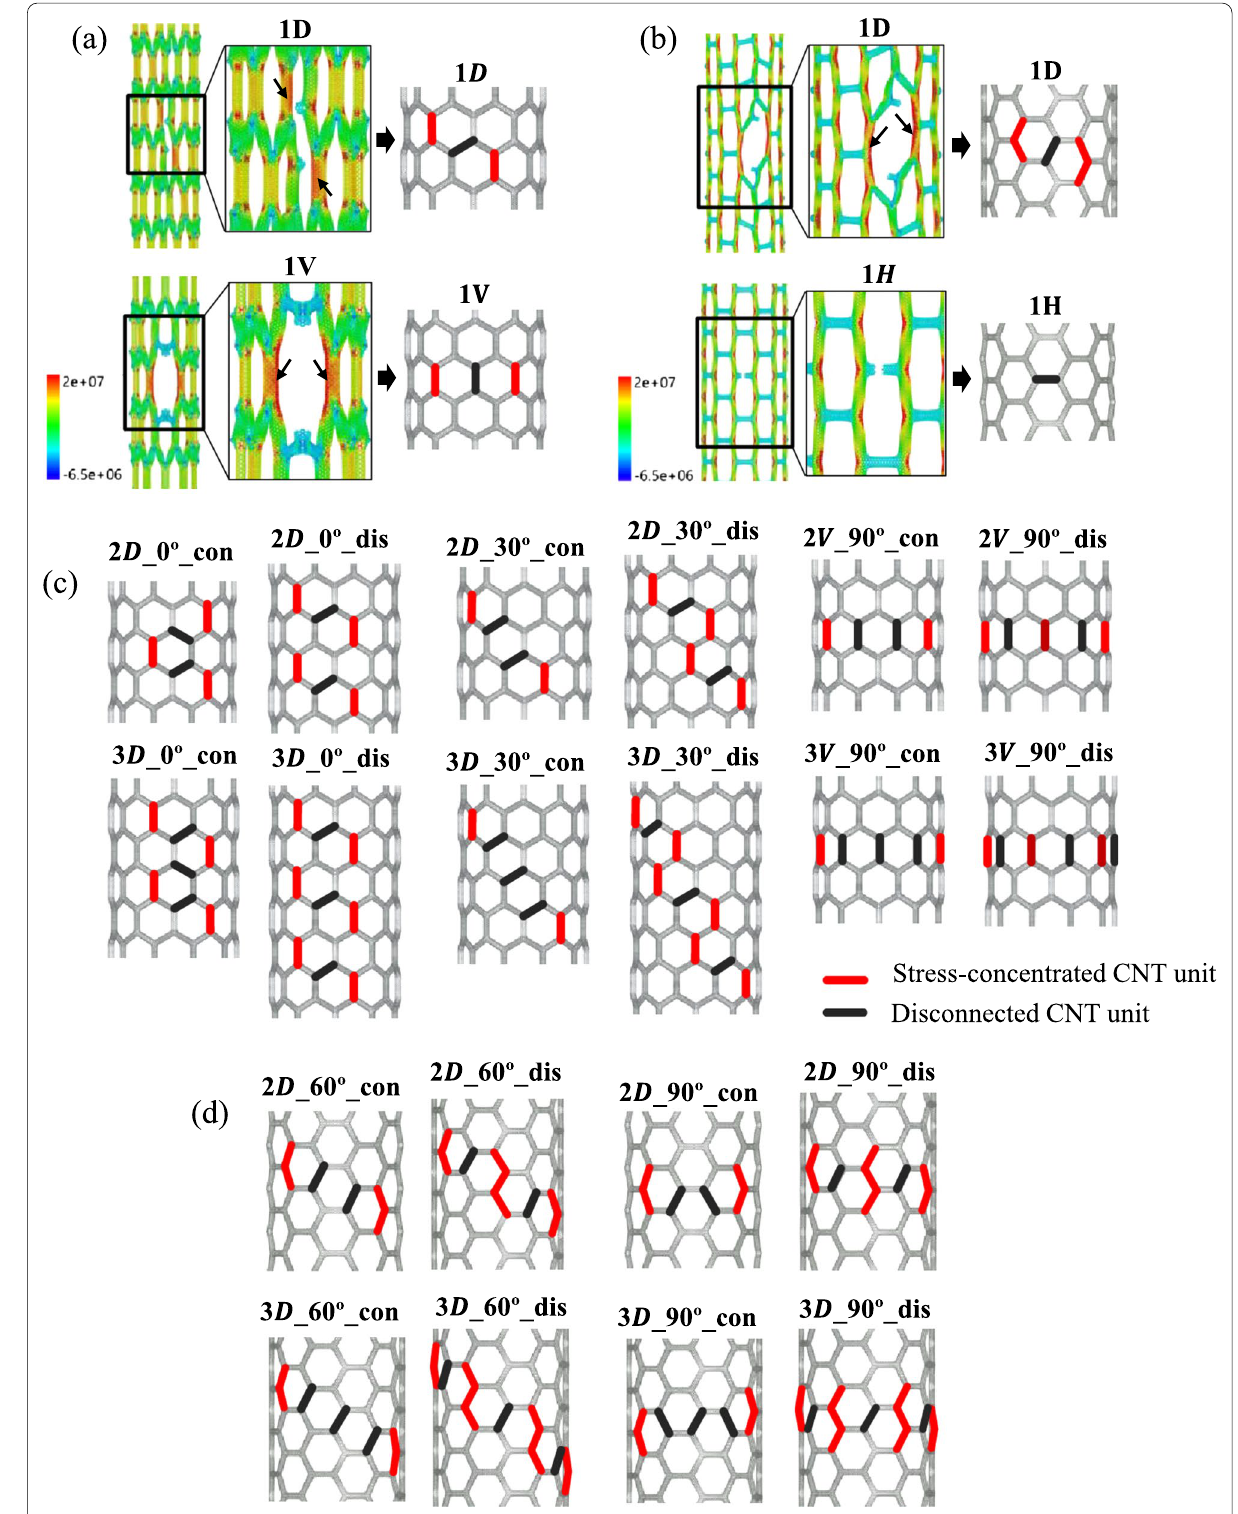
Fig. 8 Stress concentration modes of the defective SCNTs. a Single-defect zigzag SCNTs; b Single-defect armchair SCNTs; c Multi-defect zigzag SCNTs; d Multi-defect armchair